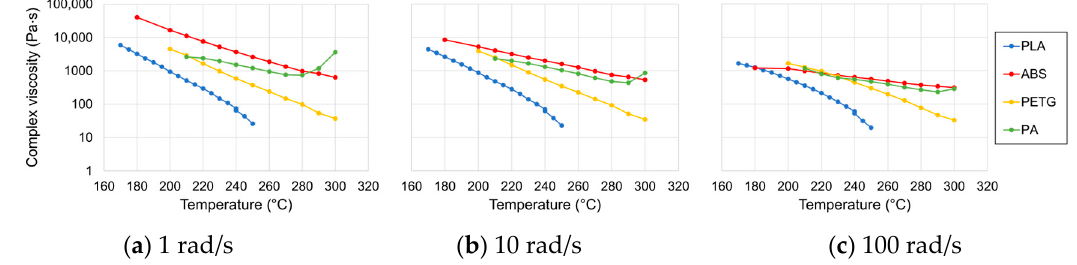
Figure 8. Complex viscosity measurements at different strain rates for the candidate polymers.